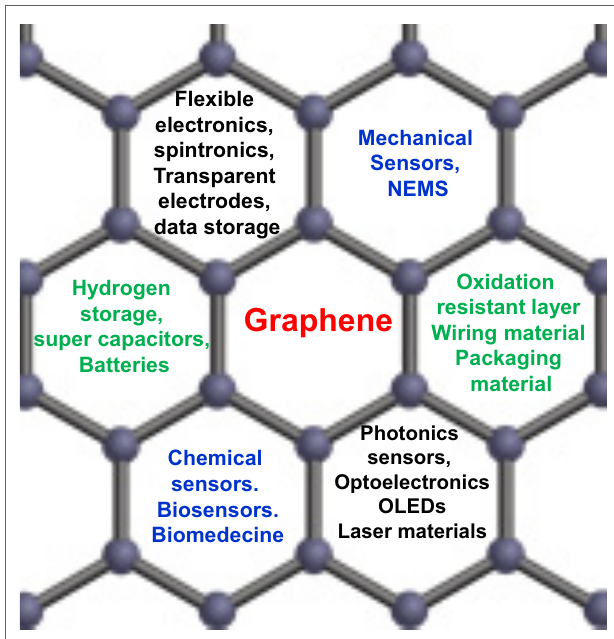
FiGURe 1 | various potential applications of graphene material